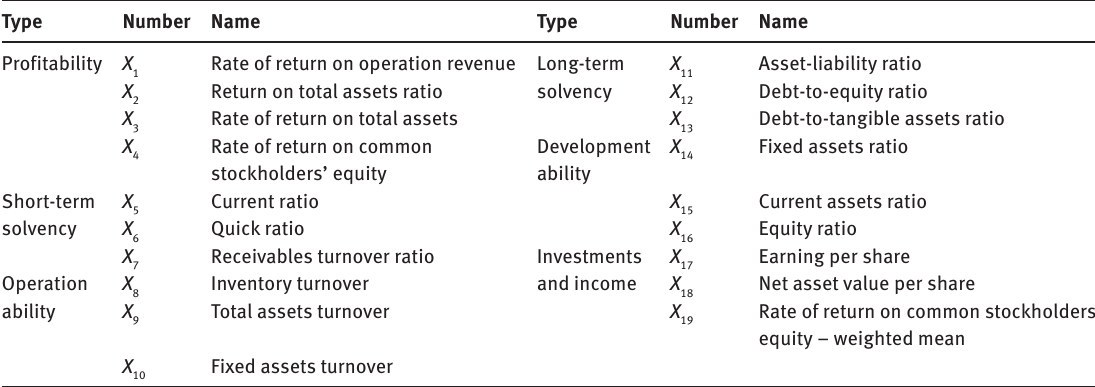
Table 1: Input of Financial